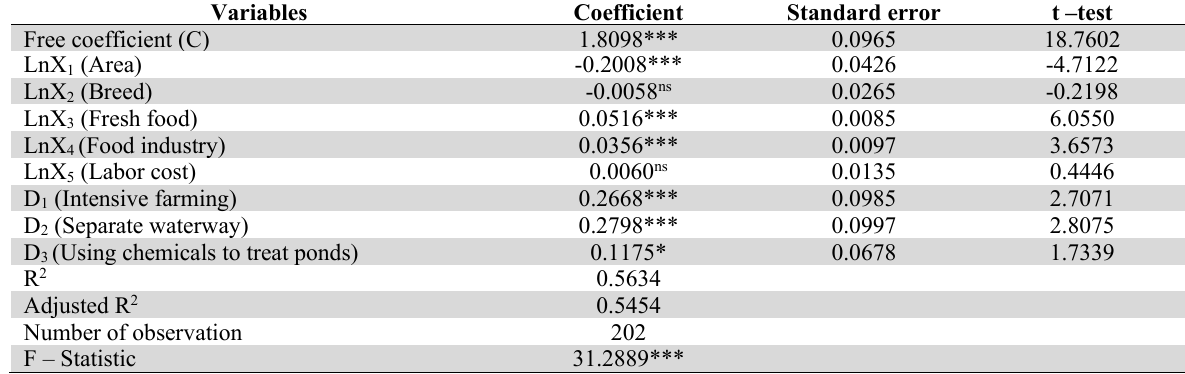
Estimated results of production function of aquaculture households in coastal provinces of